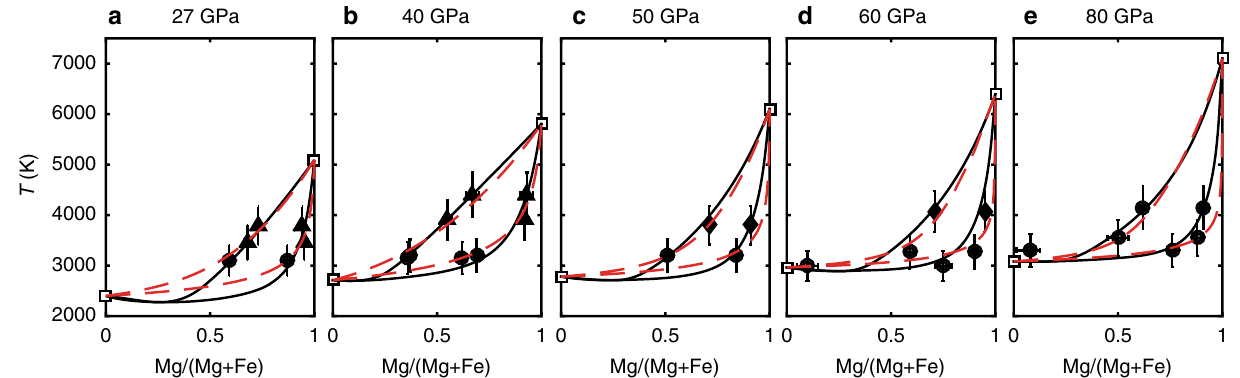
Fig. 2 The phase diagrams of ferropericlase. Curves in a – e show the ideal (red, dashed) and regular solid solution models (black, solid) at 27, 40, 50, 60, and 80 GPa, respectively. The solid symbols represent the composition of melt and coexisting ferropericlase (solid circles, triangles and diamonds represent data from this study, refs. 12,49 respectively). Uncertainties (95% con fi dence interval) for temperatures and compositions are shown and listed in the Supplementary Table 1. Temperatures are measured and corrected using the multi-layer inverse modeling method (Supplementary Table 1) 49 . FeO and MgO melting temperatures (open squares) are taken from refs. 14,19 respectively